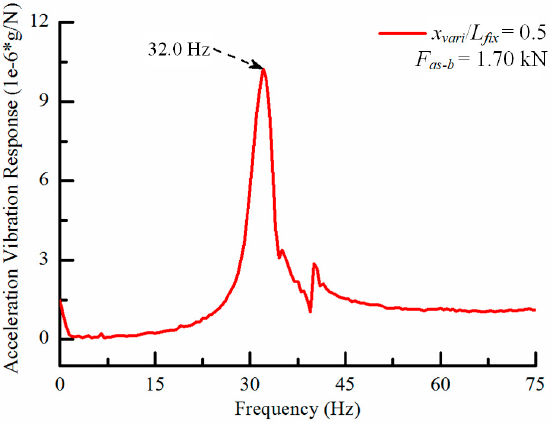
Figure 7. Frequency response of the feed system in the static state. Table 3. Theoretical and experimental results of system frequency under static state.